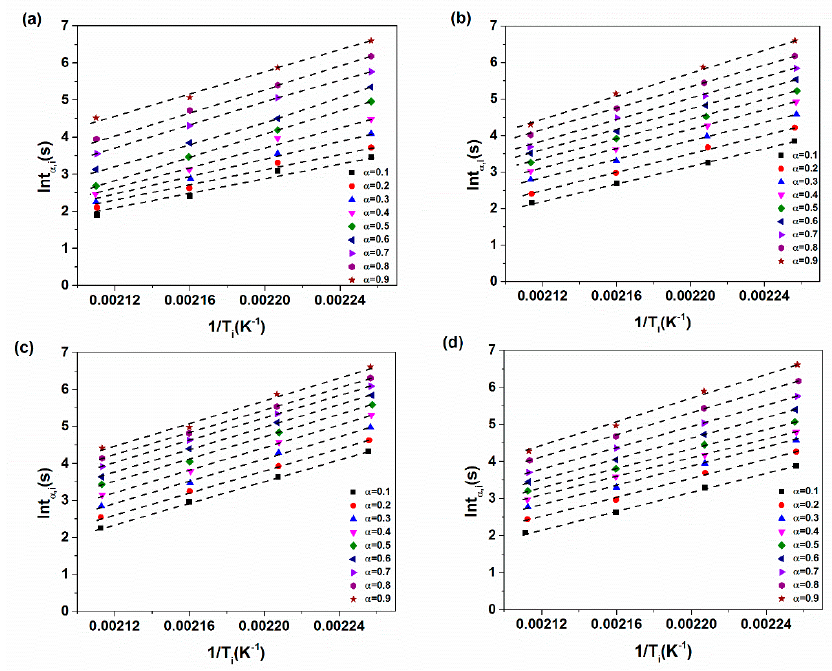
Figure 3. Plots of lnt α ,i vs. 1/Ti for various XNBR/epoxy/XHNTs nanocomposites ( a ) XE15 ( b ) XE15H3 ( c ) XE15H5 ( d ) XE15H7.